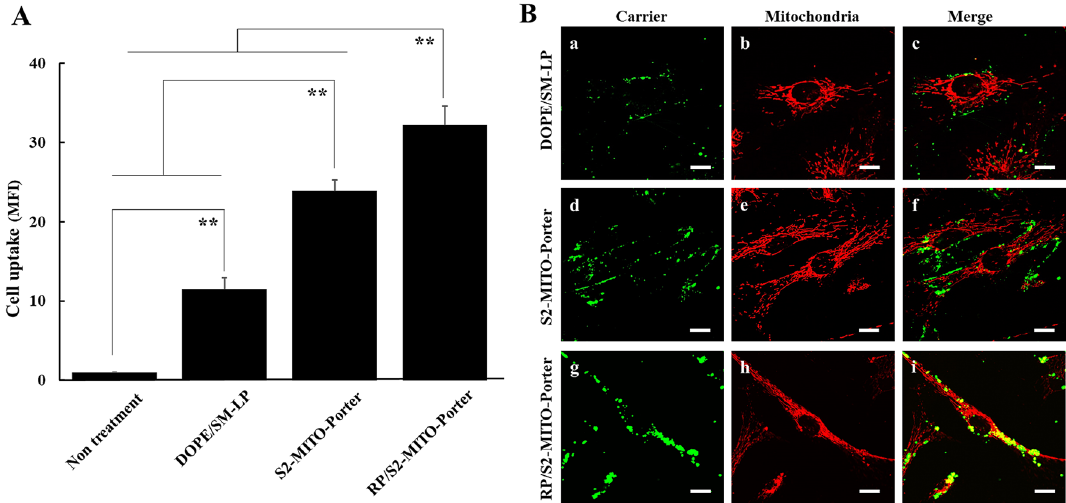
Figure 3. Intracellular observation of MITO-Porter (RES). ( A ) Cellular uptake of RP/S2-MITO-Porter (RES), S2-MITO-Porter (RES) and DOPE/SM-LP (RES) labeled with NBD-lipids were evaluated by flow cytometry, using CPCs. The quantitative analysis of cellular uptake using the mean fluorescence intensity (MFI) of the carriers. Data are represented as the mean with S.D. (n = 3). The significant differences were calculated using one-way ANOVA followed by SNK test (**p < 0.01). ( B ) Intracellular observation of DOPE/SM-LP (RES) ( a – c ), S2-MITO-Porter (RES) ( d – f ) and RP/S2-MITO-Porter (RES) ( g – i ) using CLSM. When green labeled carriers (green color) were co-localized with red stained mitochondria, yellow signals were observed in the merged image. Lines indicate the edges of the cells. Scale bars 20